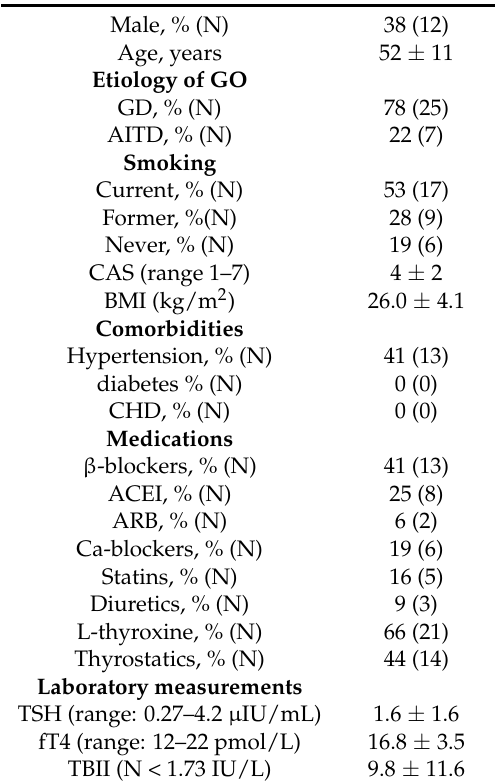
Table 4. Baseline characteristics of study population (N =